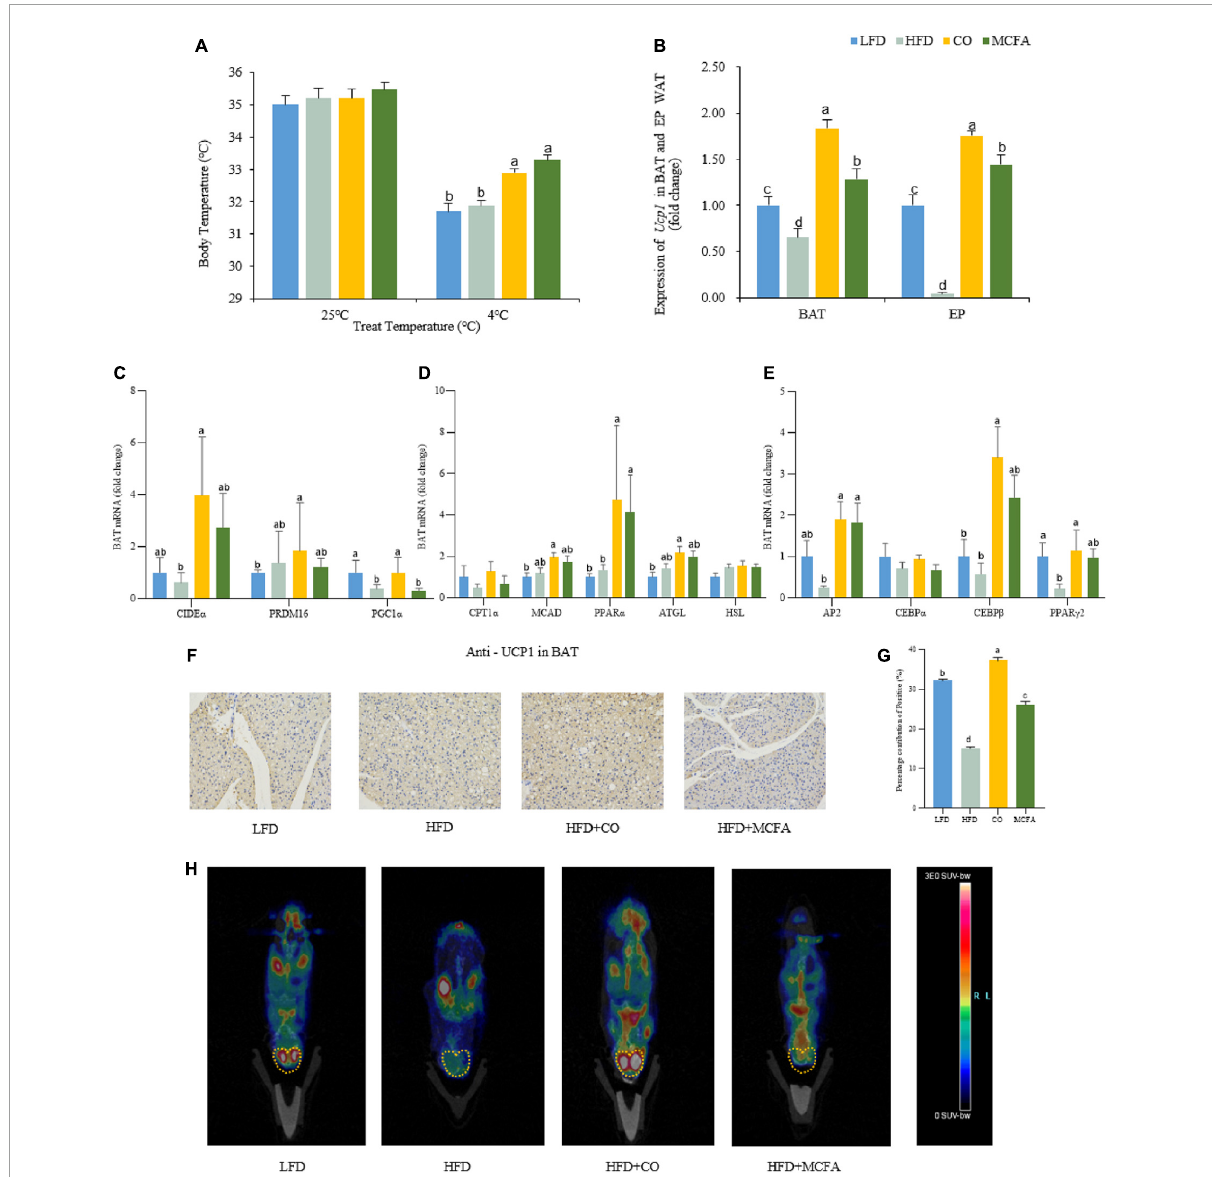
FIGURE4 CO and MCFA maintain core body temperature by increasing BAT activity. (A) The core body temperature of the treated mice at room temperature (25 ◦ C) and cold challenge conditions (4 ◦ C for 4 h) ( n = 12). (B) Ucp1 expression profile in BAT and EP WAT, real-time PCR analysis of Ucp1 expression ( n = 12). (C–E) Gene expression profile in BAT, real-time PCR analysis of thermogenic, lipolytic, fatty oxidation, fatty acid synthesis and browning-related gene expression profile. (F,G) Immunohistochemistry for the UCP1 protein (brown stain) in the BAT sections